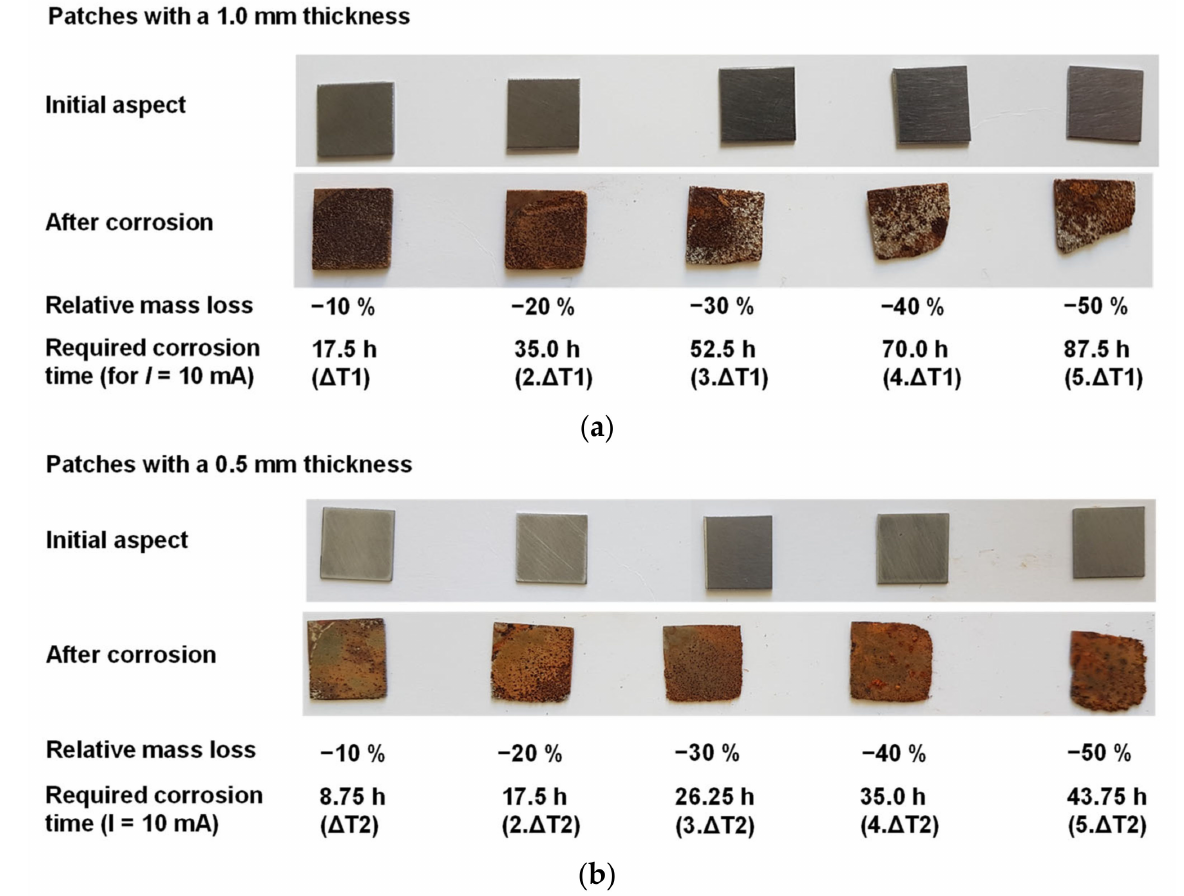
Figure 7. Aspect before and after the accelerated corrosion of five patches with ( a ) 1.0 mm thickness and ( b ) 0.5 mm thickness. The expected Relative Mass Loss (corrosion indicator) and the required time of accelerated corrosion to reach it are indicated below each